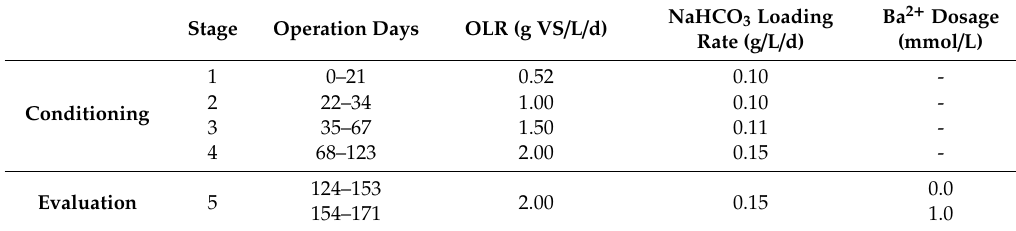
Table 5. Summary of ASHR operation